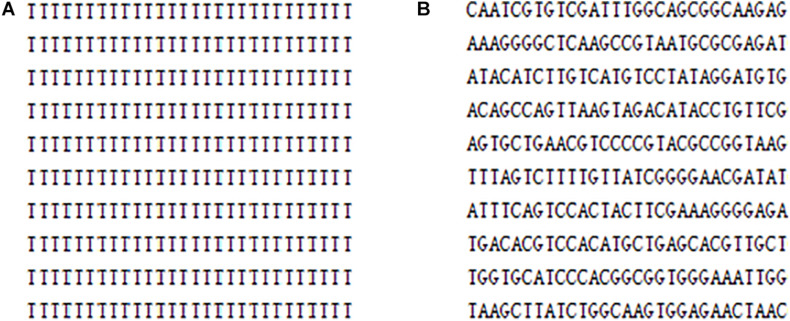
The part of DNA encoding matrix of “pure white” image: (A) DNA fixed encoding (B) DNA dynamic encoding of the proposed algorithm.